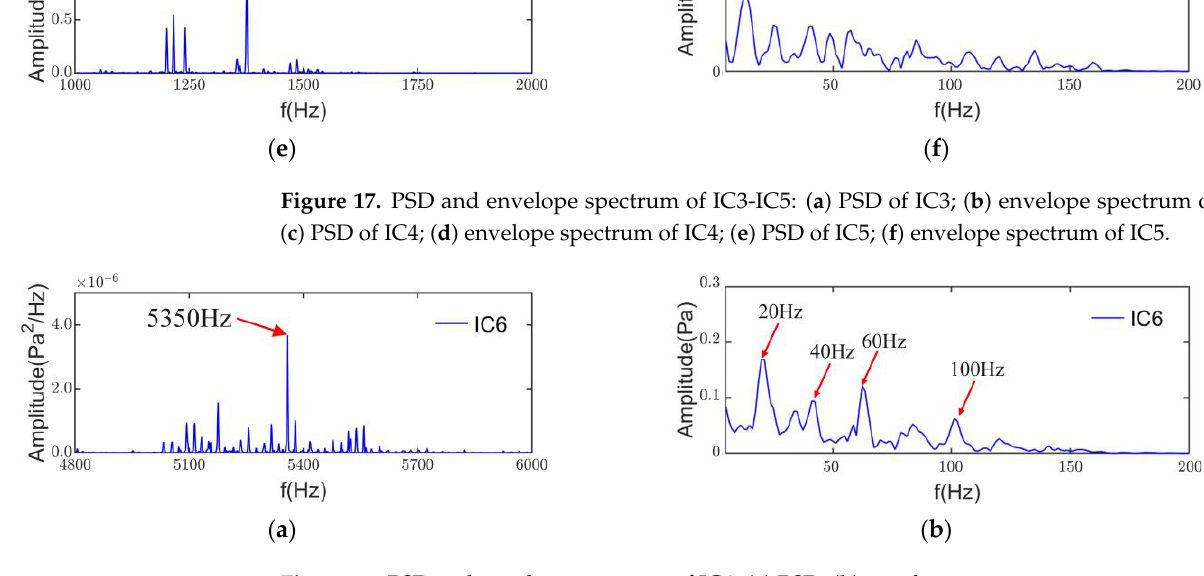
Figure 18. PSD and envelope spectrum of IC6: ( a ) PSD; ( b ) envelope spectrum .